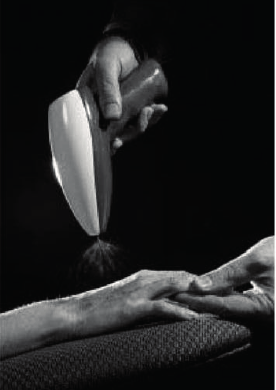
Figure 4. Showing the use of nanofibers for wound dressing. Reprinted with permission from Elsevier, 2003